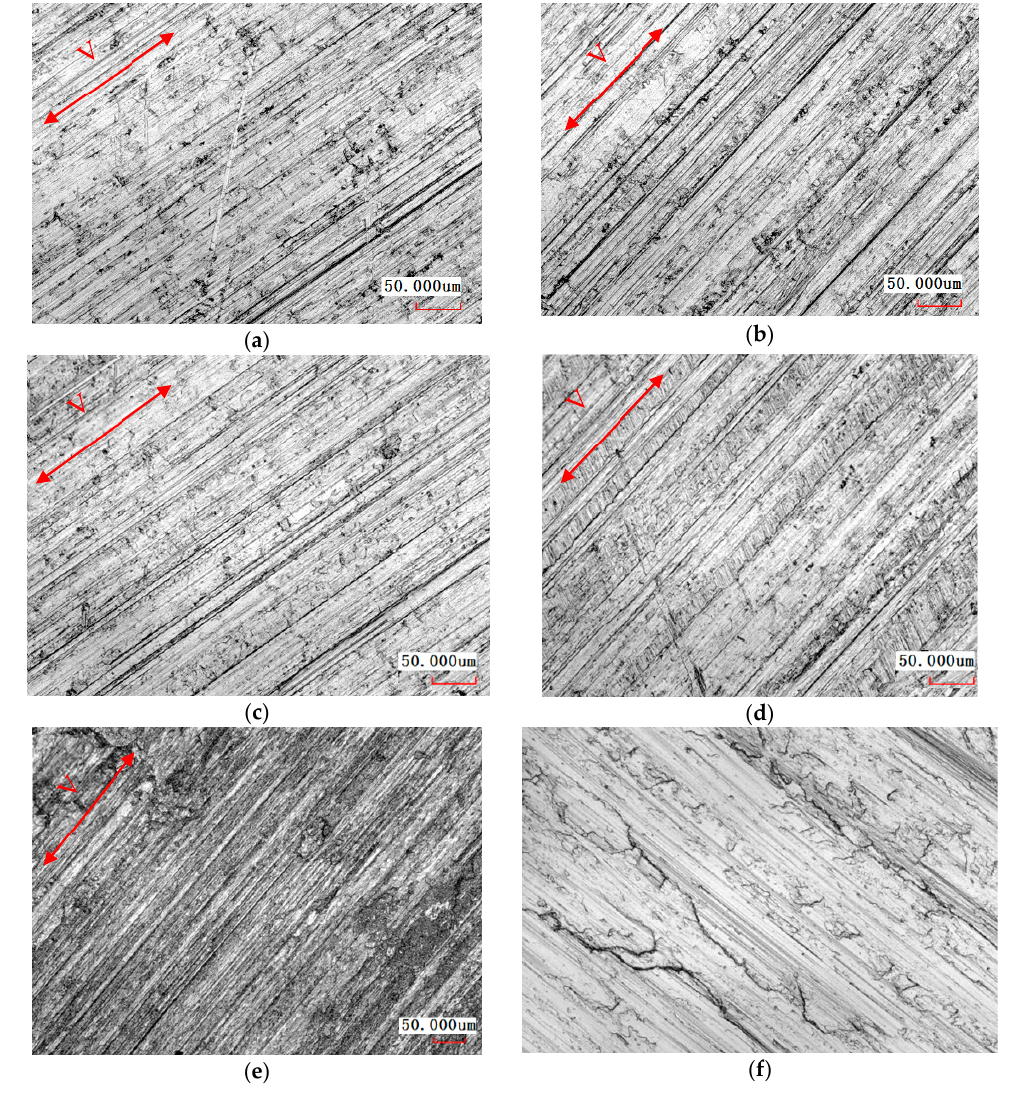
Figure 4. Surface morphology at different temperatures. ( a ) T = 25 °C; ( b ) T = 100 °C; ( c ) T = 150 °C; ( d ) T = 200 °C; ( e ) T = 250 °C; ( f ) Original sheet.